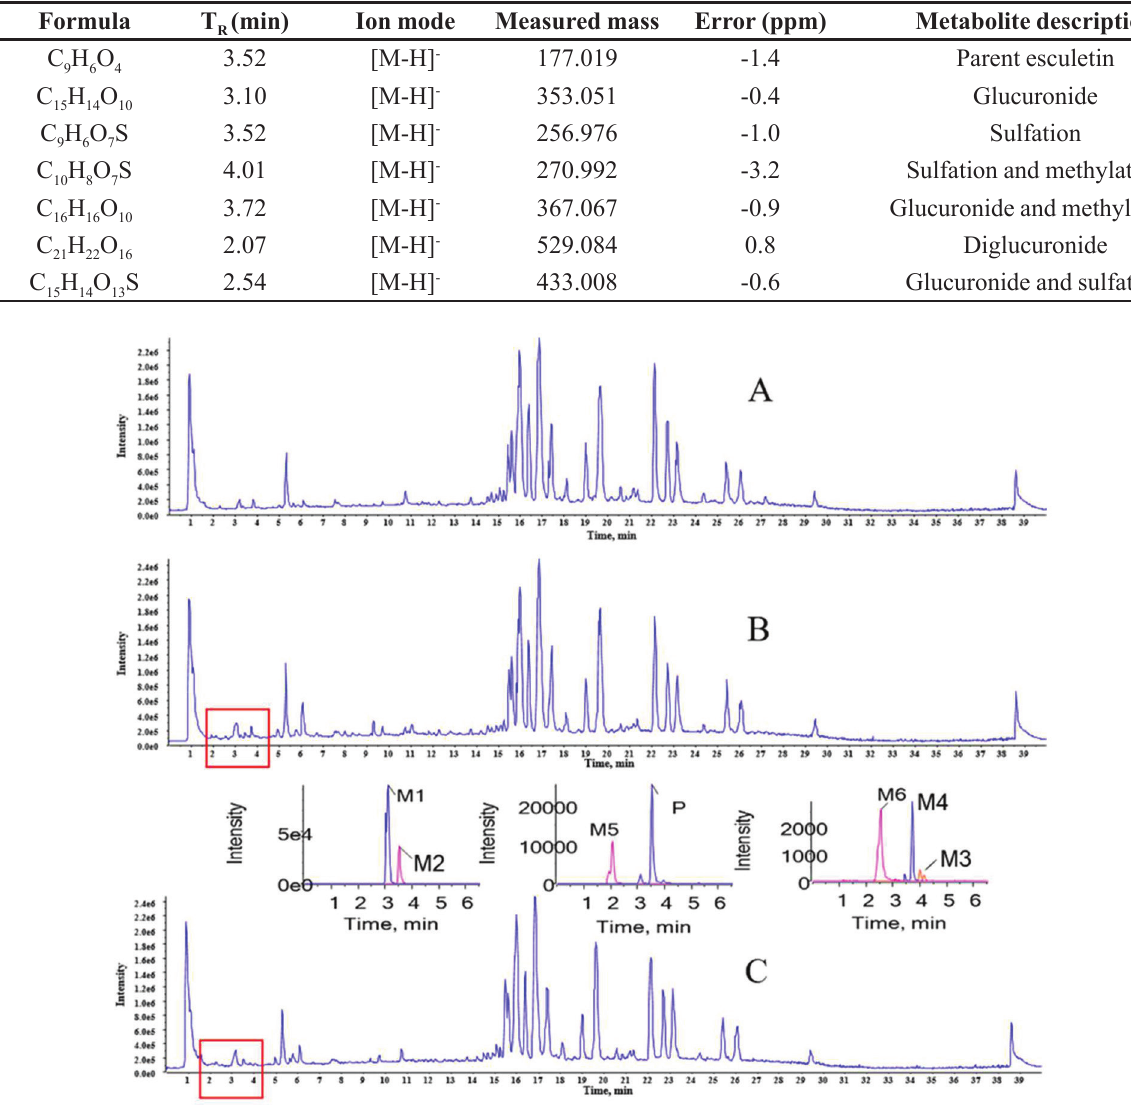
FIGURE 4 - Total ion chromatogram and extract ion chromatogram of esculetin and metabolites from mice serum samples in negative ion mode. (A) Untreated hyperuricemic mice; (B) Erding extract-treated hyperuricemic mice; (C) esculetin-treated hyperuricemic mice. P: parent esculetin C methylation metabolite C M6: glucuronide and sulfation metabolite C